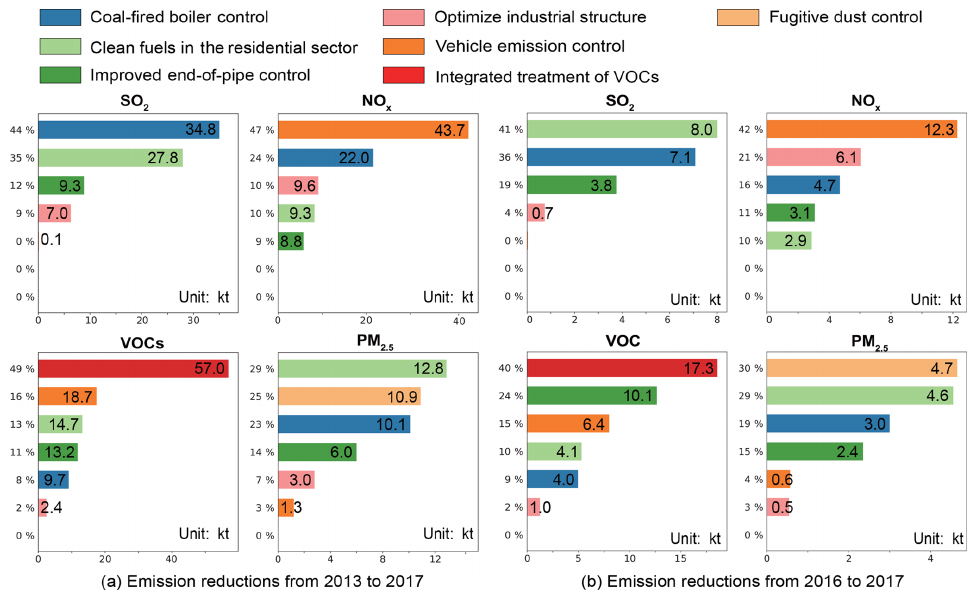
Figure 5. Emission reductions of SO 2 , NO x , VOCs, and primary PM 2 . 5 attributed to seven types of control policies in Beijing for the periods of 2013–2017 (a) and 2016–2017 (b) . The relative contribution of each policy to the total emission reduction is presented on the Y axis. The number on each bar represents the absolute emission reductions by the relevant control policy.